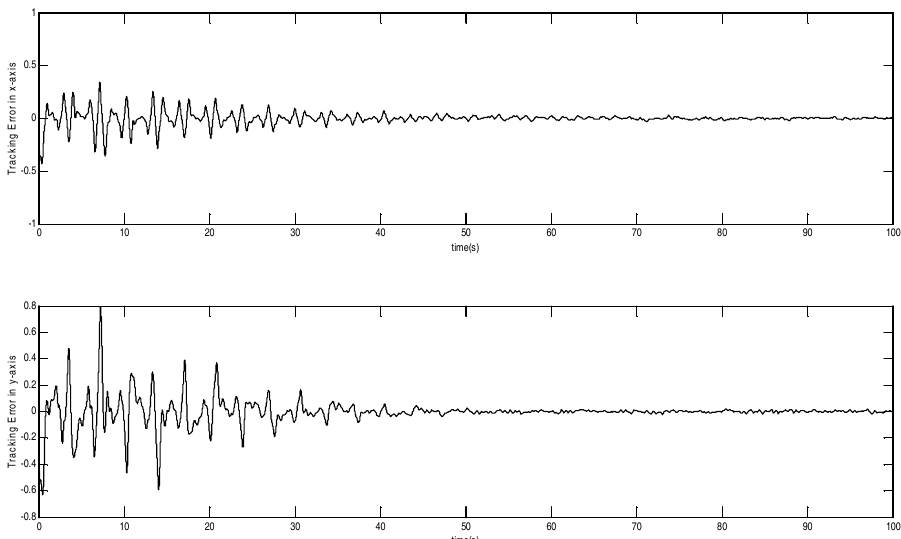
Figure 4. Tracking error using adaptive dynamic sliding mode control based on the backstepping approach.